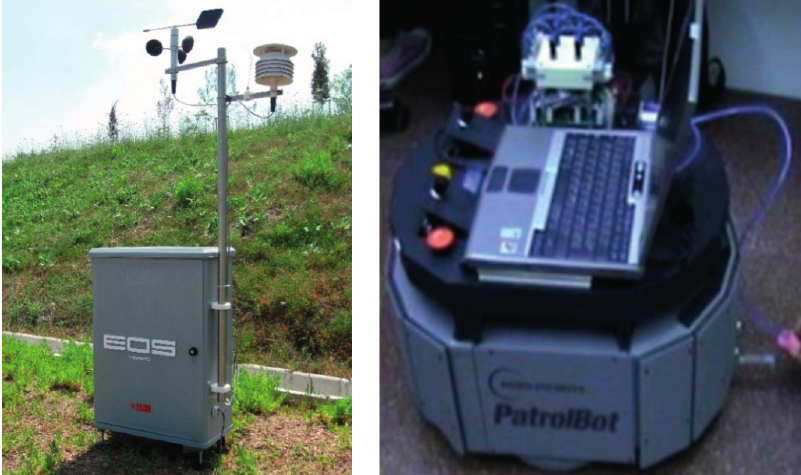
Figure 1. Examples of electronic noses: on the left, the EOS electronic nose by Dentoni et al. [105] for outdoor monitoring and, on the right, the mobile MCE-nose by Gonzalez-Jimenez et al.